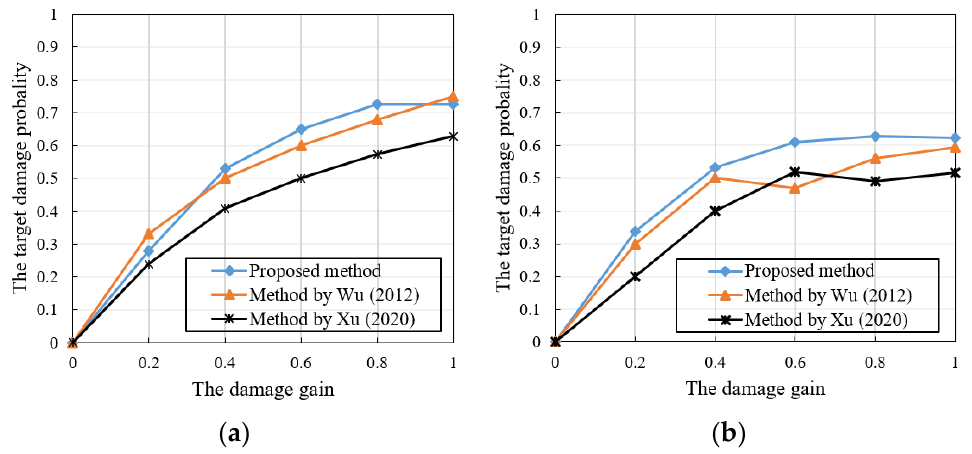
Figure 8. The relationship curve between the damage gain and the target damage probability under different damage game strategies: ( a ) The relationship curve between the damage gain and the target damage probability under the game damage strategy is (X9, Y9); ( b ) The relationship curve between the damage gain and the target damage probability under the game damage strategy is (X6, Y6) [3,7].